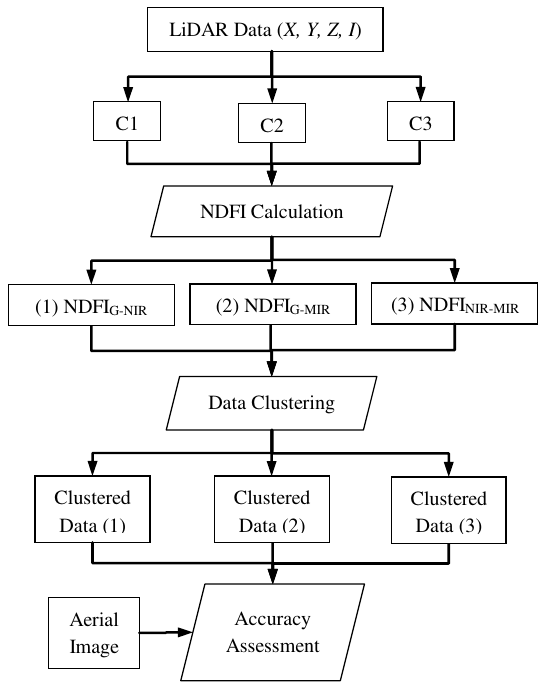
Figure 4. The overall